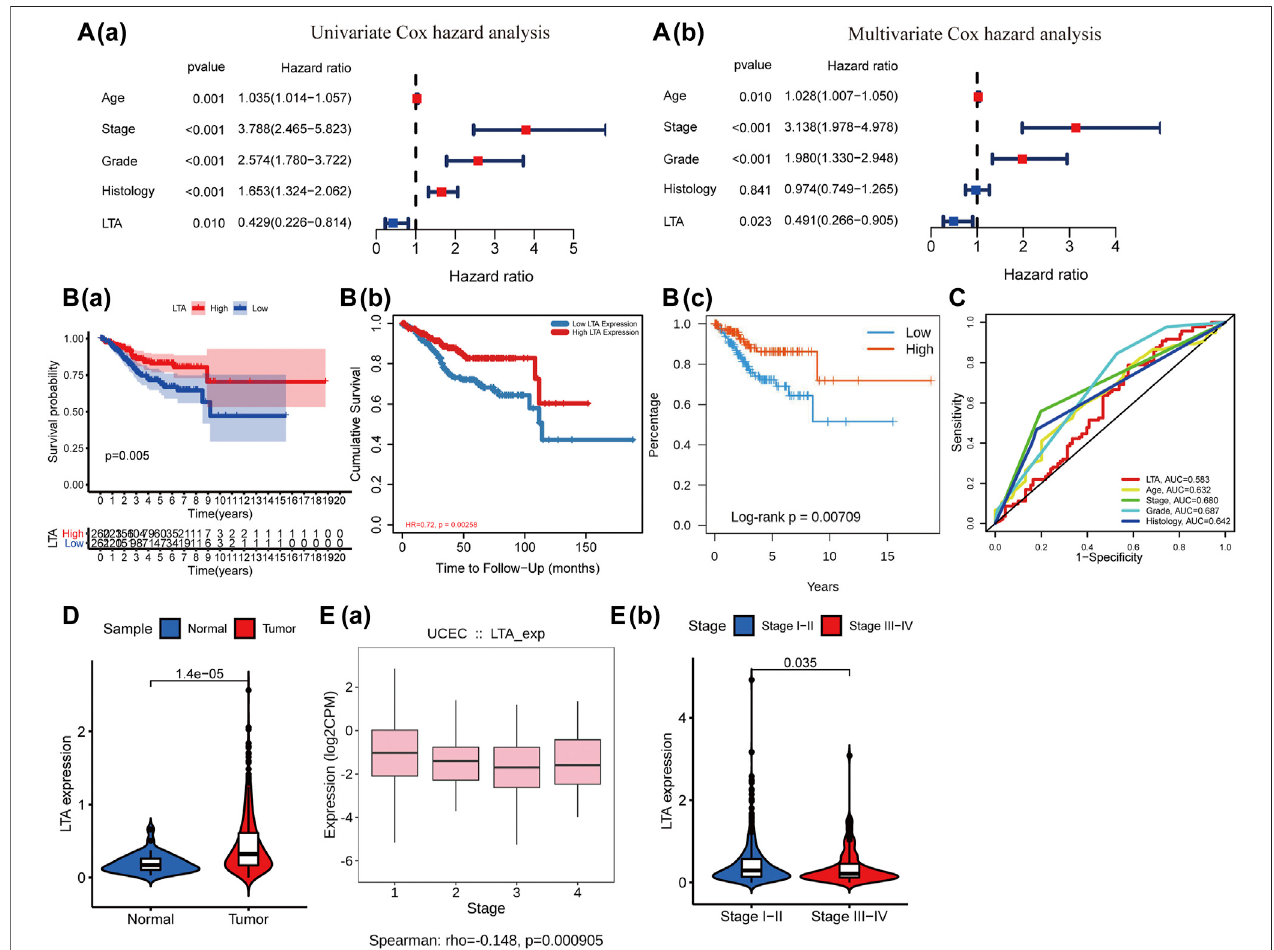
FIGURE2| RelationshipofLTAandthecommonclinicalfeatures. (A) CoxregressionanalysisofLTAandthecommonclinicalfeatures,andthehazardratioofLTA was 0.491 with 95% CI (0.266 – 0.805) ( p = 0.023) in multivariate Cox hazard analysis. (B) Survival curve of LTA, (a) Kaplan – Meier survival method, (b) TIMER, and (c) TISIDB. (C) ROC analysis of LTA and the common clinical features. (D) The difference of LTA expression in tumor and normal tissues. (E) The correlation between LTA expression and tumor stage (a) and the distribution of LTA expression in earlier stages (stages I – II) and advanced stages (stages III – IV) (b) .